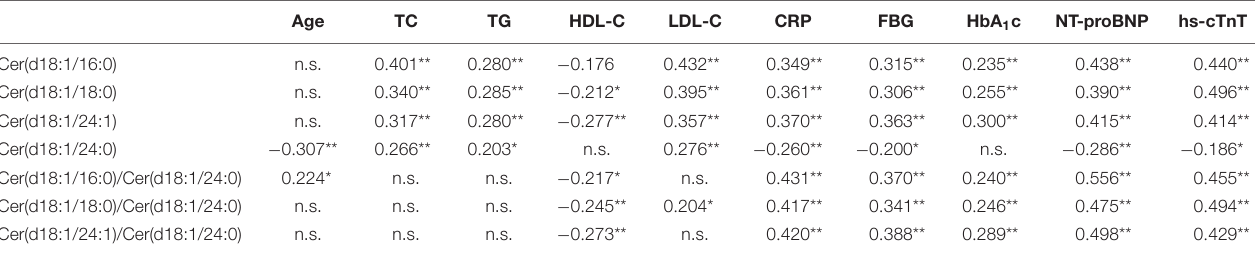
TABLE 2 | Spearman rank correlation coefficients between ceramides and traditional cardiovascular risk factors for the whole study population ( n = 130). Age TC TG HDL-C LDL-C CRP FBG HbA 1 c NT-proBNP